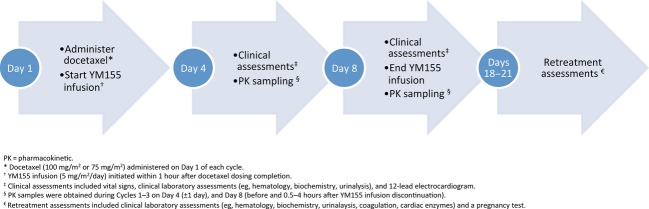
Study flow diagram.